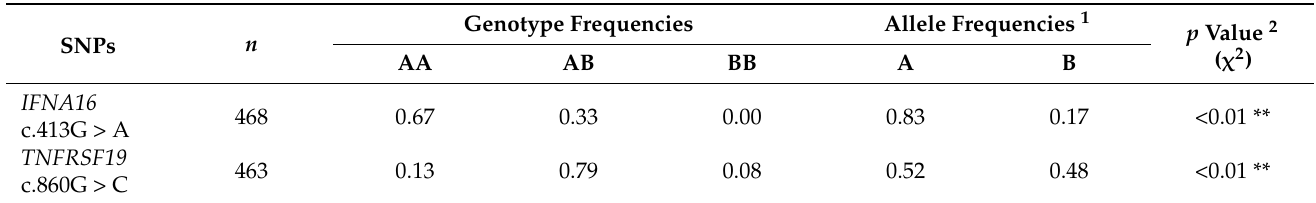
Table 2. Genotype and allele frequencies of porcine IFNA16 and TNFRSF19 genes in